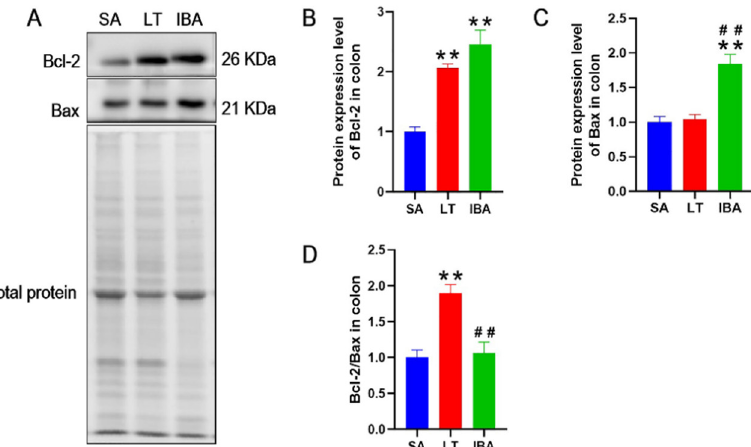
Figure 13. ( A ) Representative immunoblot images of Bcl-2 and Bax proteins in colon tissue of Daurian ground squirrels. ( B ) Statistical graph of protein expression level of Bcl-2. ( C ) Statistical graph of protein expression level of Bax. ( D ) Statistical graph of Bcl-2 /Bax ratio. SA summer active; LT, late torpor; IBA, interbout arousal. Mean ± SEM. n = 3. Compared with SA group, ** p < 0.01. Compared with LT group, ## p < 0.01.